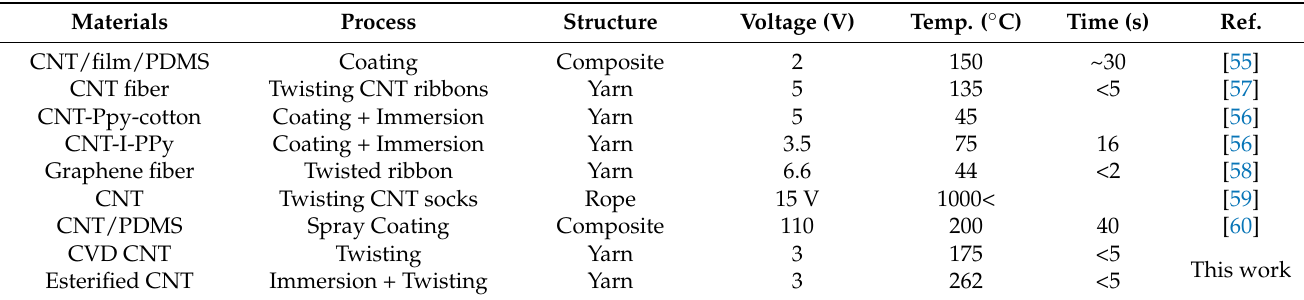
Figure 5. ( a ) E-heating stability of pristine, acidifed, and esterified CNT yarn under 3.0 V; ( b ) Changes of steady-state maximum temperature (T max ) at different applied voltages; of pristine, acidified, and esterified CNT yarn ( c ) Cyclic E-heating behaviors of Esterified CNT yarn; ( d ) Representation of flexibility of CNT yarn in bent and twisted fabric ( e ) E-heating behaviors of CNT yarn embedded in a fabric and ( f ) Application of CNT yarn in a pillow as decoration and E-heating. The esterified CNT yarn has shown high heating temperature at low trigger voltage with a quick response time, showing outstanding electro-thermal properties compared with other heating materials due to its inherited and crosslinked structure as shown in Table 1. The esterified yarn with covalent bridge between CNTs results in higher E-heat- ing properties than other non-covalently bonded CNTs yarn, i.e. , CNT with PDMS and CNT-Ppy-cotton [55,56]. Table 1. E-heating properties and performance of classic heating materials.